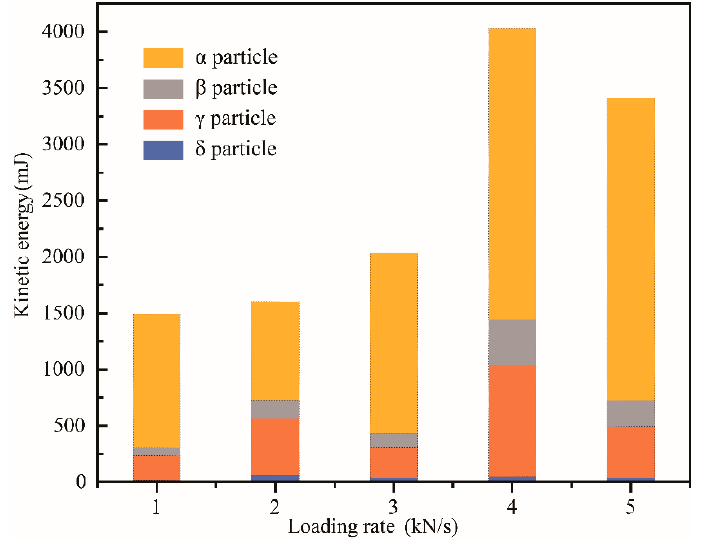
Figure 9. The kinetic energy of four particles under different loading rates.